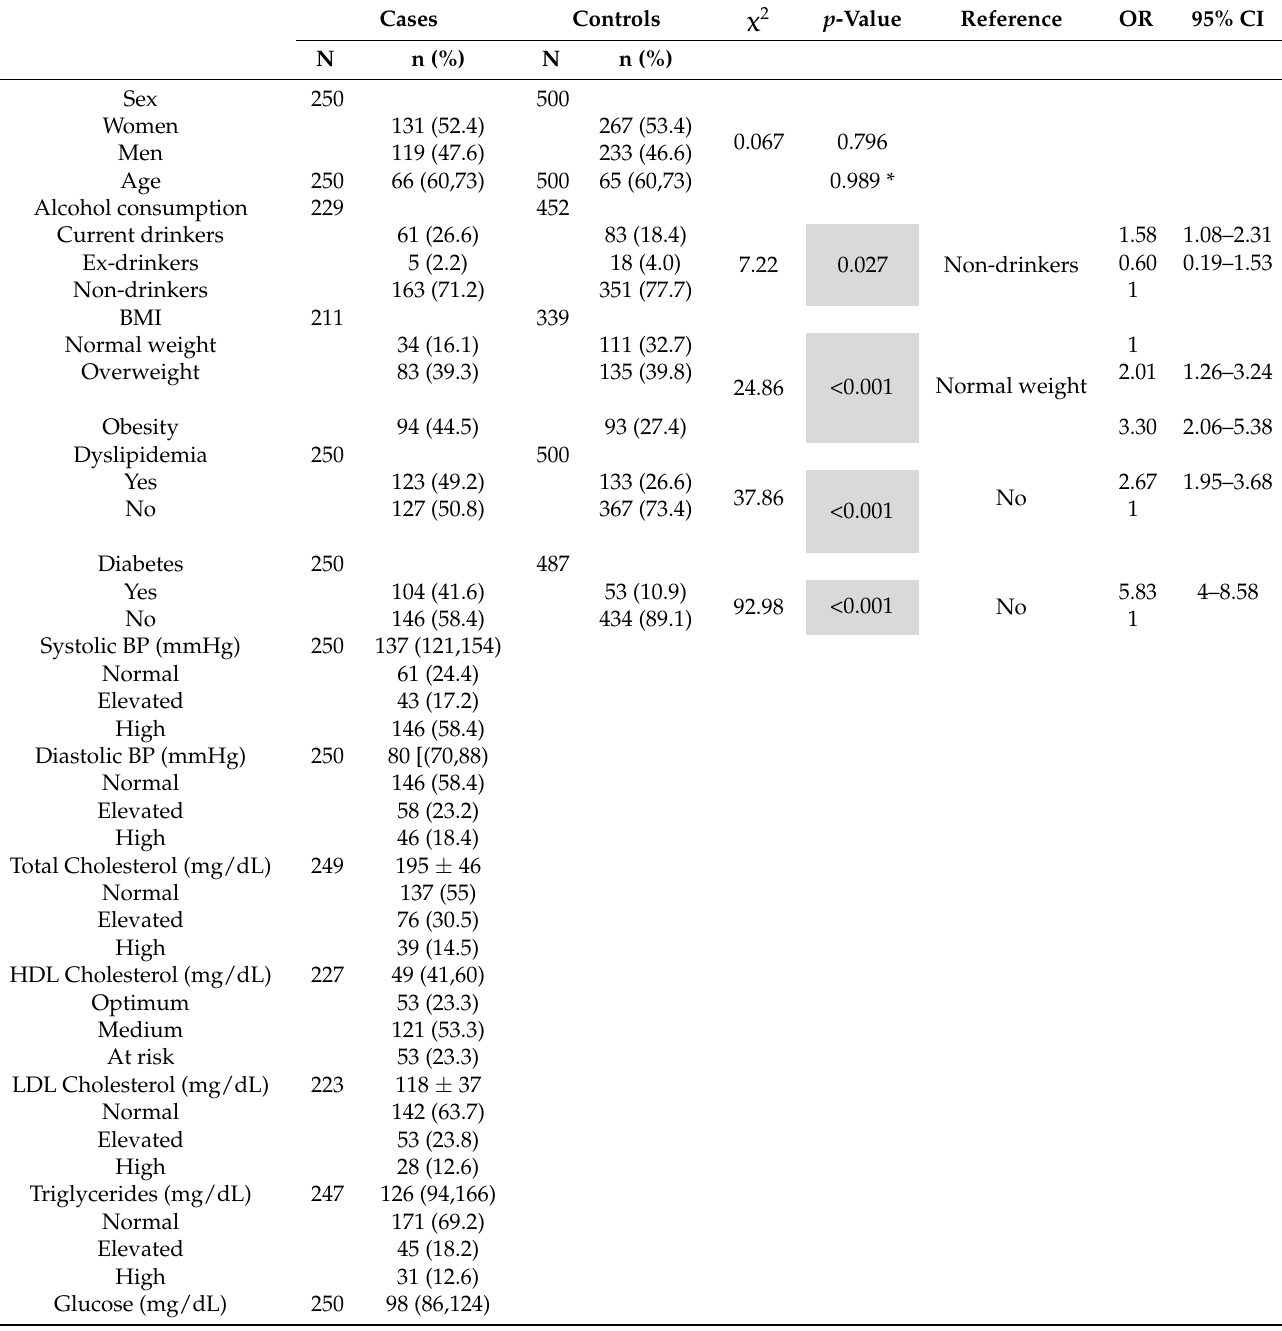
Table 1. Clinicopathological characteristics of HBP cases and